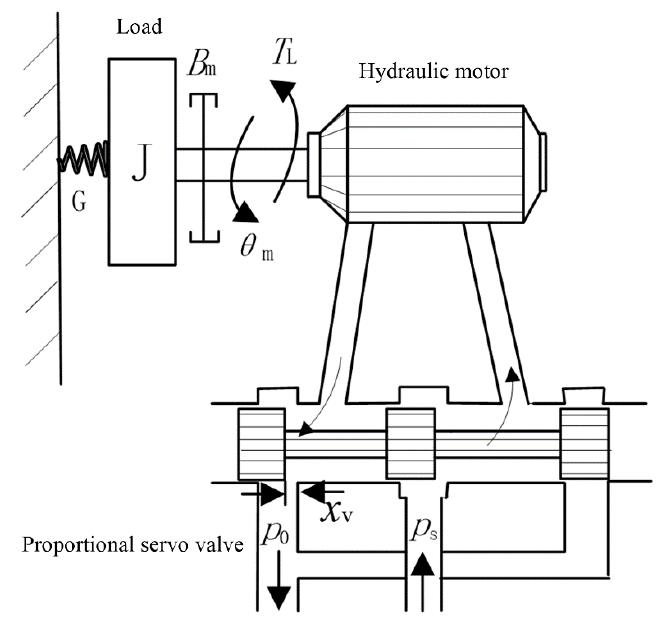
Figure 7. Schematic diagram of the valve-controlled hydraulic motor.